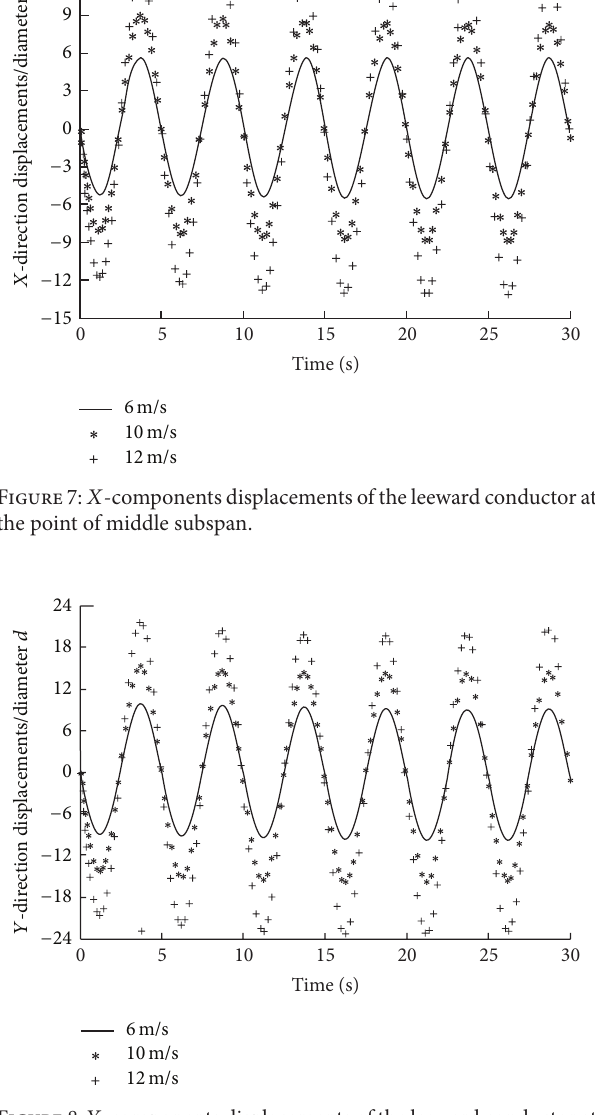
Figure 8: 𝑌 -components displacements of the leeward conductor at the point of middle